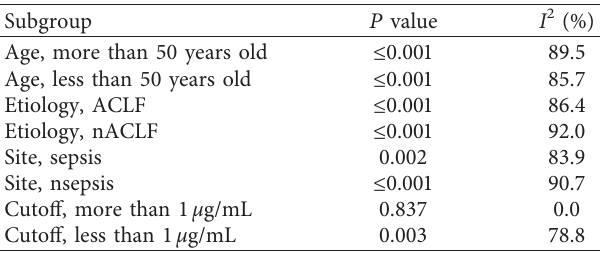
Table 3: Meta-analysis results derived from subgroup analysis using serum procalcitonin as a marker for bacterial infection in liver failure